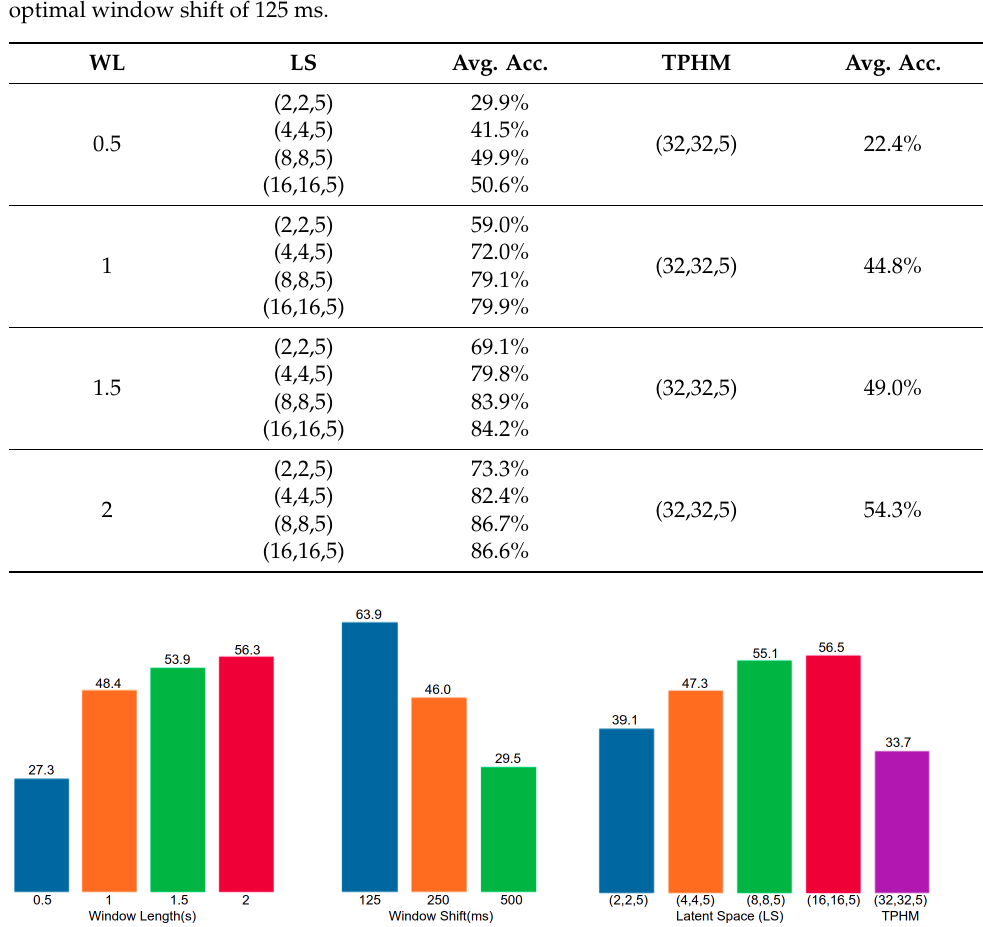
Table 3. Average accuracies of the classification models for all the participants trained with latent spaces (LS) and the original topographic maps (TPHM), grouped by window length (WL) for the optimal window shift of 125 ms.